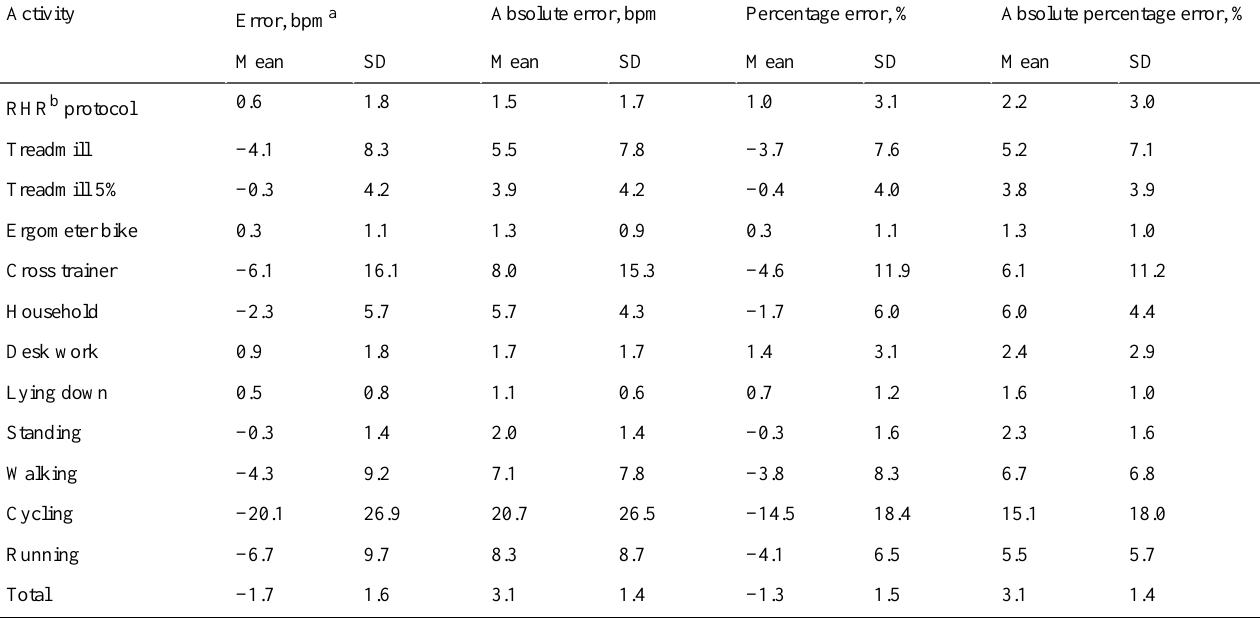
Table 4. Heart rate errors compared with electrocardiogram-based reference that were calculated using 10-second nonoverlapping windows, as means and standard deviations, expressed in beats per minute and percentages.